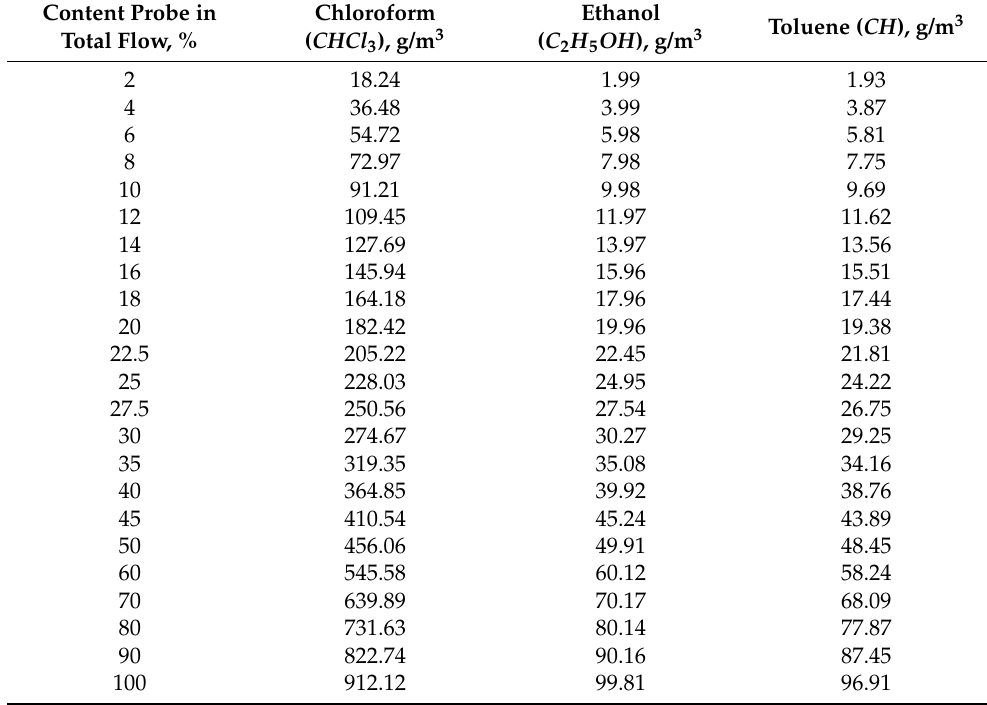
Table 1. Vapor concentration of the test substances at 20 ◦